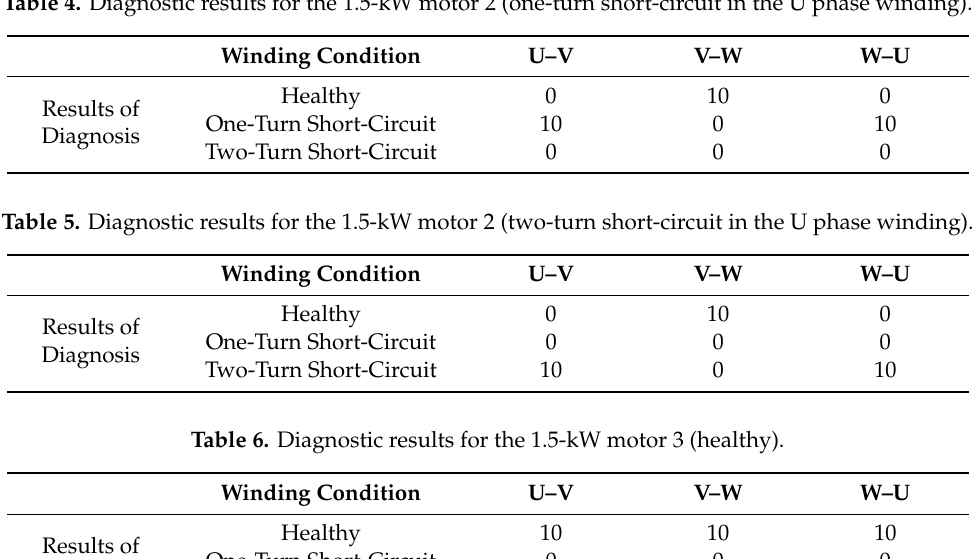
Table 4. Diagnostic results for the 1.5-kW motor 2 (one-turn short-circuit in the U phase winding).